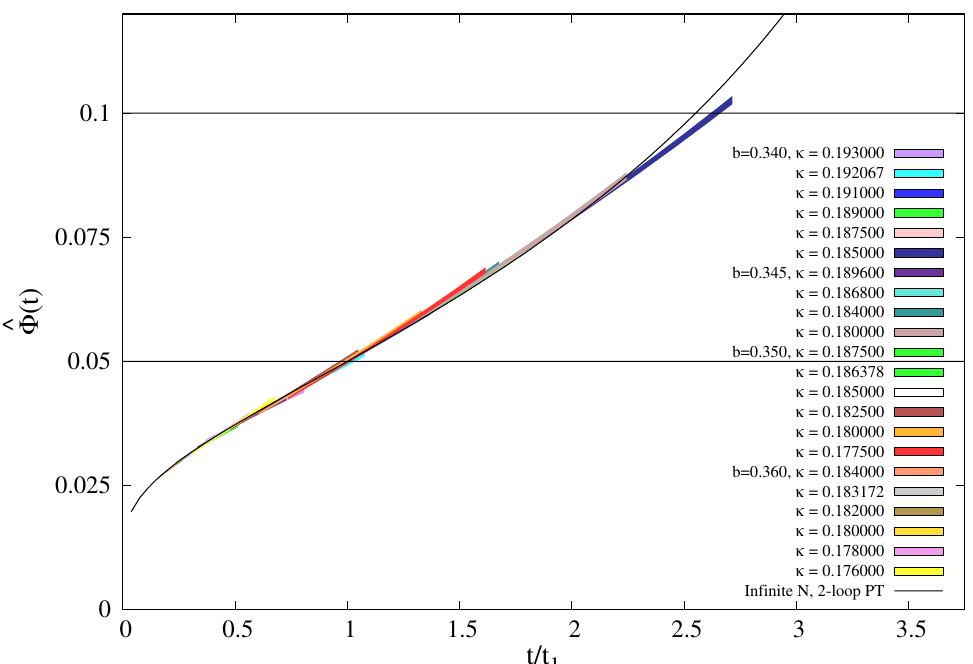
Figure 6. We display ˆΦ( t ) as a function of t/t N = 289 . The width 1 for all our datasets with of the coloured bands indicates the error on the different quantities. The black line on the plot corresponds to the two-loop infinite N (infinite volume) perturbative prediction for the flow-time dependence of ˆΦ( t )